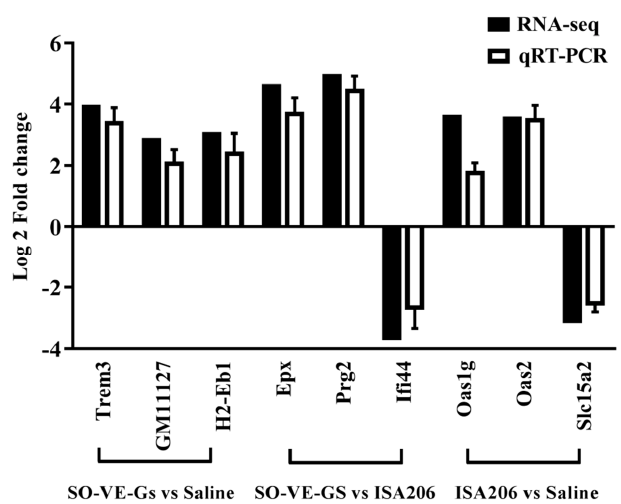
Figure 10. Validation of DEGs by RT-qPCR. Data were normalized to the expression of GAPDH, and the log two-fold changes were calculated in comparison to the corresponding groups.